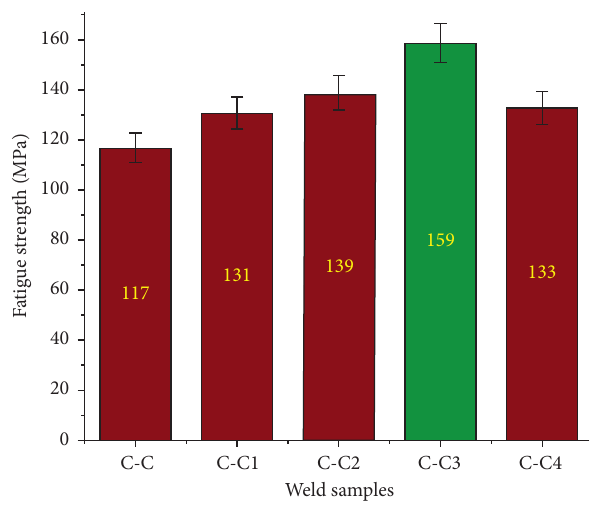
Figure 5: Fatigue strength of the weld